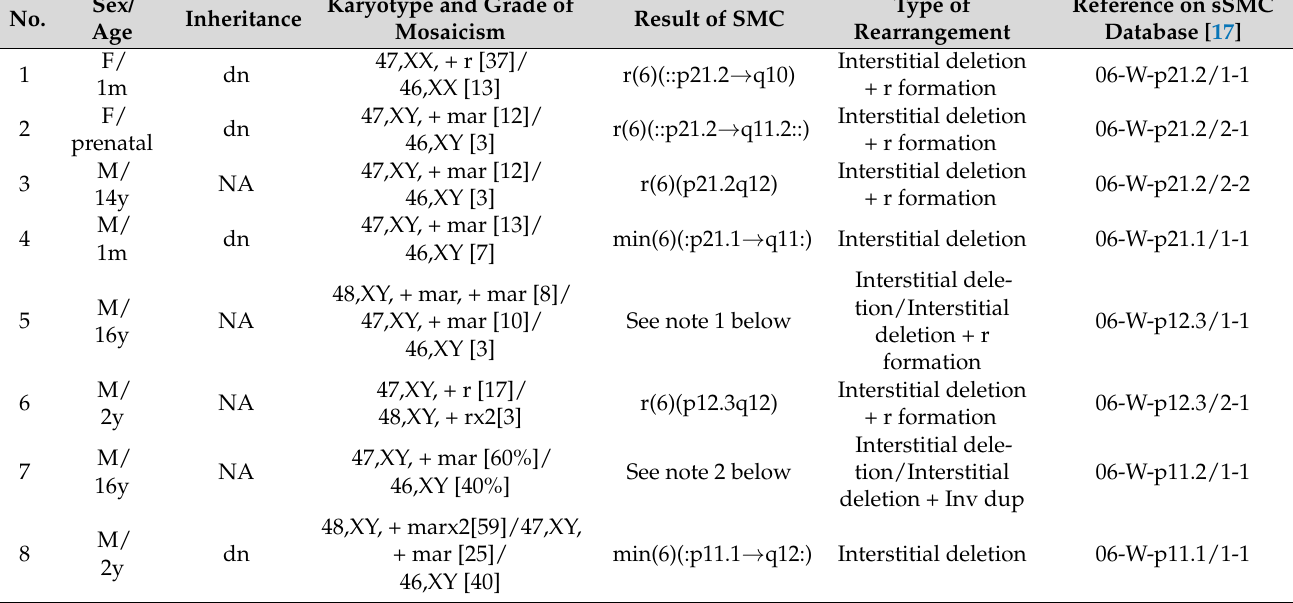
Table 1. Comparison of cases with clinical findings associated with